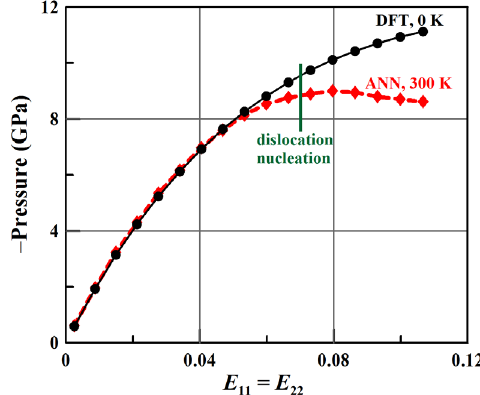
Figure 6. Comparison of DFT calculations at 0 K with the results of the trained ANN for the tensor equation of state at 300 K in the case of hydrostatic tension of solid pore-free single crystal aluminum; the green vertical line shows the threshold of dislocation nucleation.